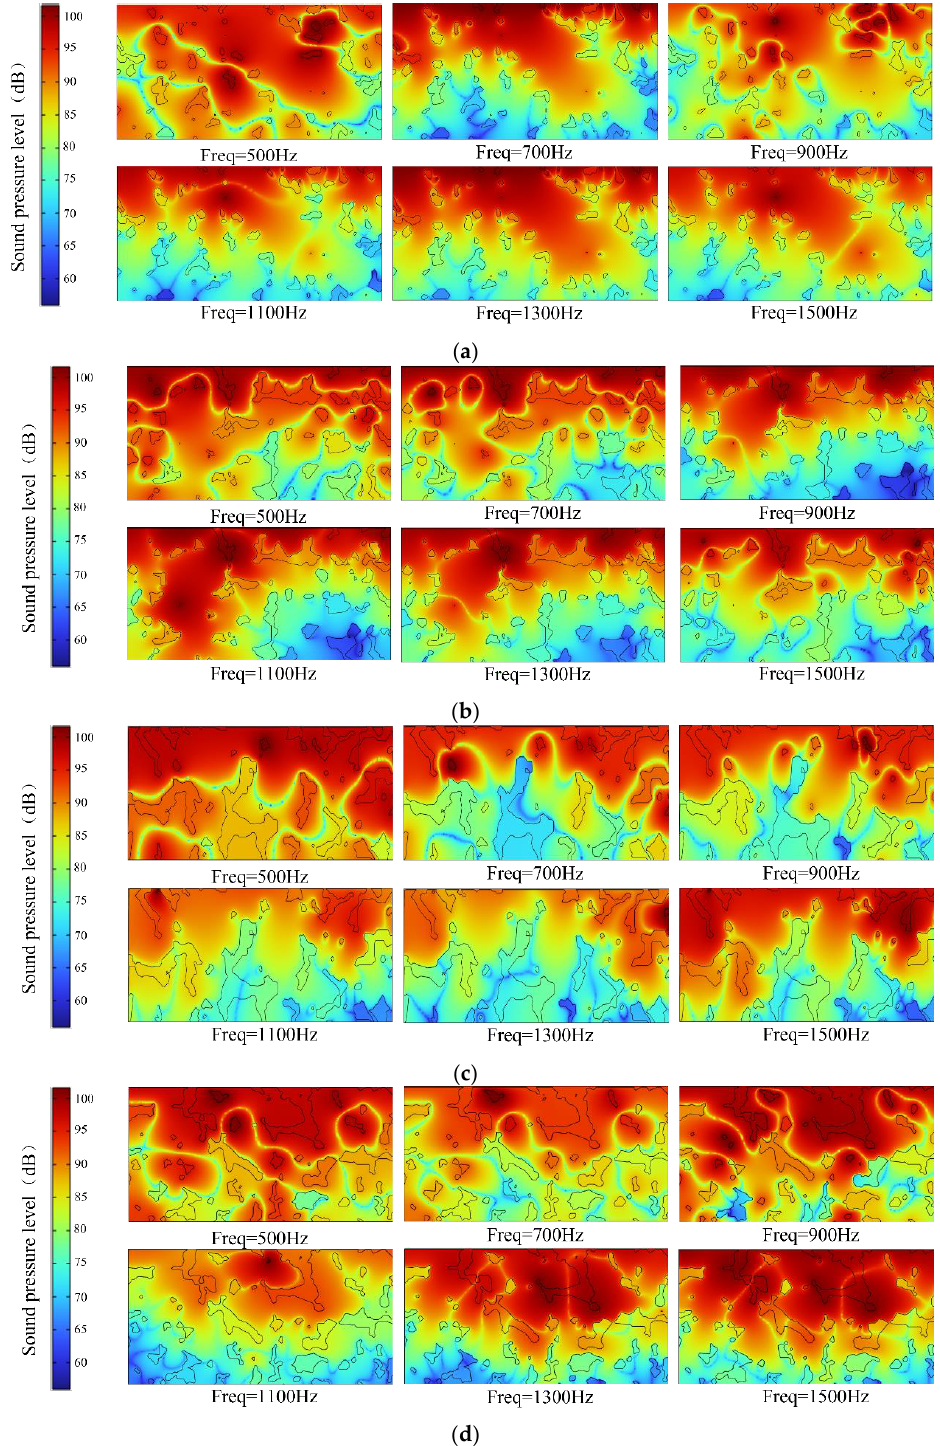
Figure 12. Sound pressure level distribution of PAC with different void contents at different frequencies: ( a ) sample A1; ( b ) sample A2; ( c ) sample A3 and ( d ) sample A4.